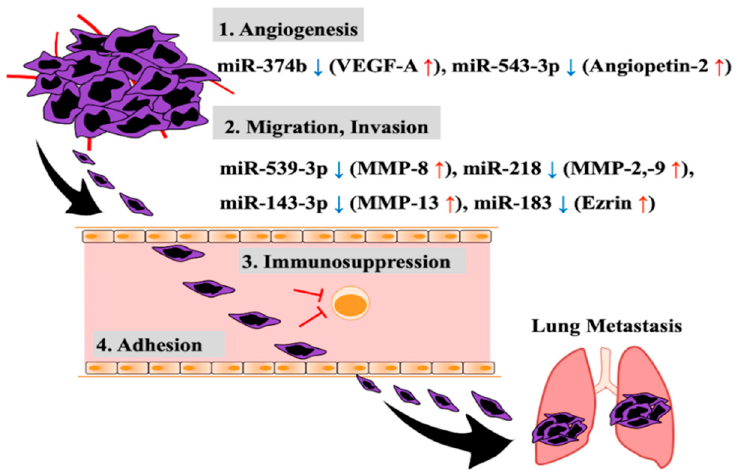
Figure 1. Dysregulated miRNAs and their target genes related to metastasis of osteosarcoma.